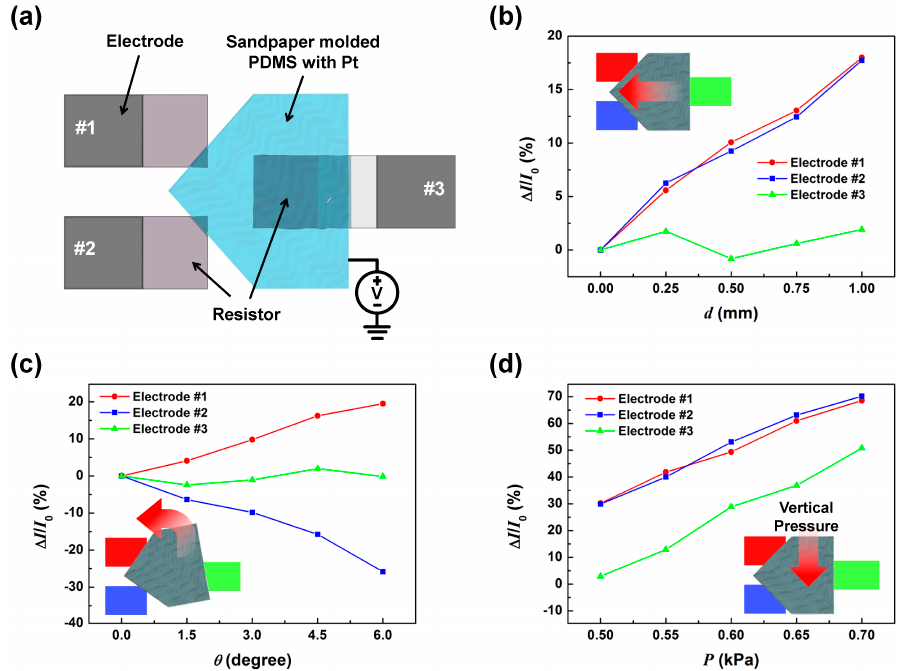
Figure 7. The triple electrode SMP (tSMP) sensor; ( a ) the schematic illustration of the tSMP sensor, and the Δ I / I 0 of electrode no. 1 (red), no. 2 (blue) and no. 3 (green) depending on applied displacement ( b ); counter-clockwise rotation ( c ); and vertical pressure ( d ). The insets show the schematic movement illustrations of SMP with color-coded electrodes; no. 1 (red), no. 2 (blue), and no. 3 (green).